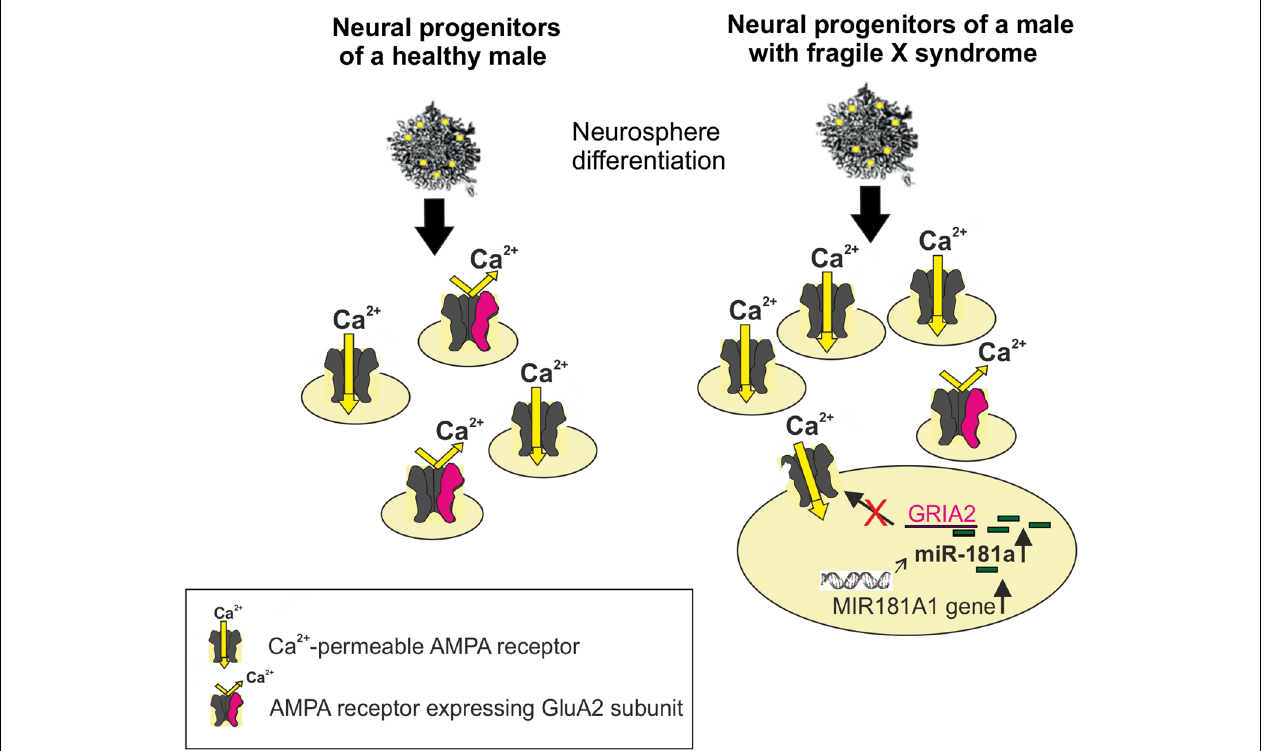
FIGURE 1 | Schematic presentation of increased differentiation of neural progenitors expressing Ca 2 + -permeable (CP; alpha-amino-3-hydroxy-5-methylisoxazole- 4-propionic acid receptor, AMPAR) from human Fragile X syndrome (FXS) induced pluripotent stem (iPS)-derived neurospheres compared with normal healthy controls. The miR-181a-mediated regulation of Ca 2 + -permeability of the AMPAR is visualized in a FXS progenitor by showing the increased expression of the MIR181A1 gene. This leads to an increase in the expression of mature miR-181a, which by interacting with the GRIA2 mRNA, can post-trascriptionally reduce the translation of the GluA2 subunit. The edited GluA2 subunit is required for Ca 2 + -impermeability of the AMPAR.